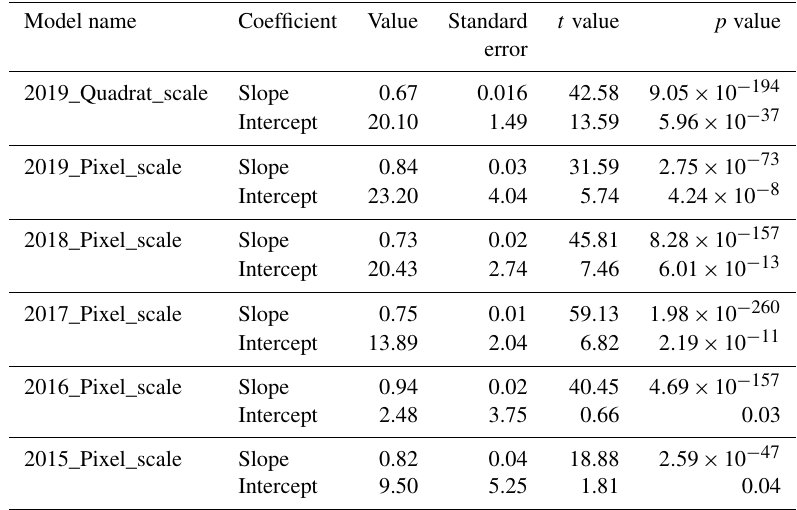
Table A4. Regression analysis for AGB estimation models at quadrat and pixel scales.